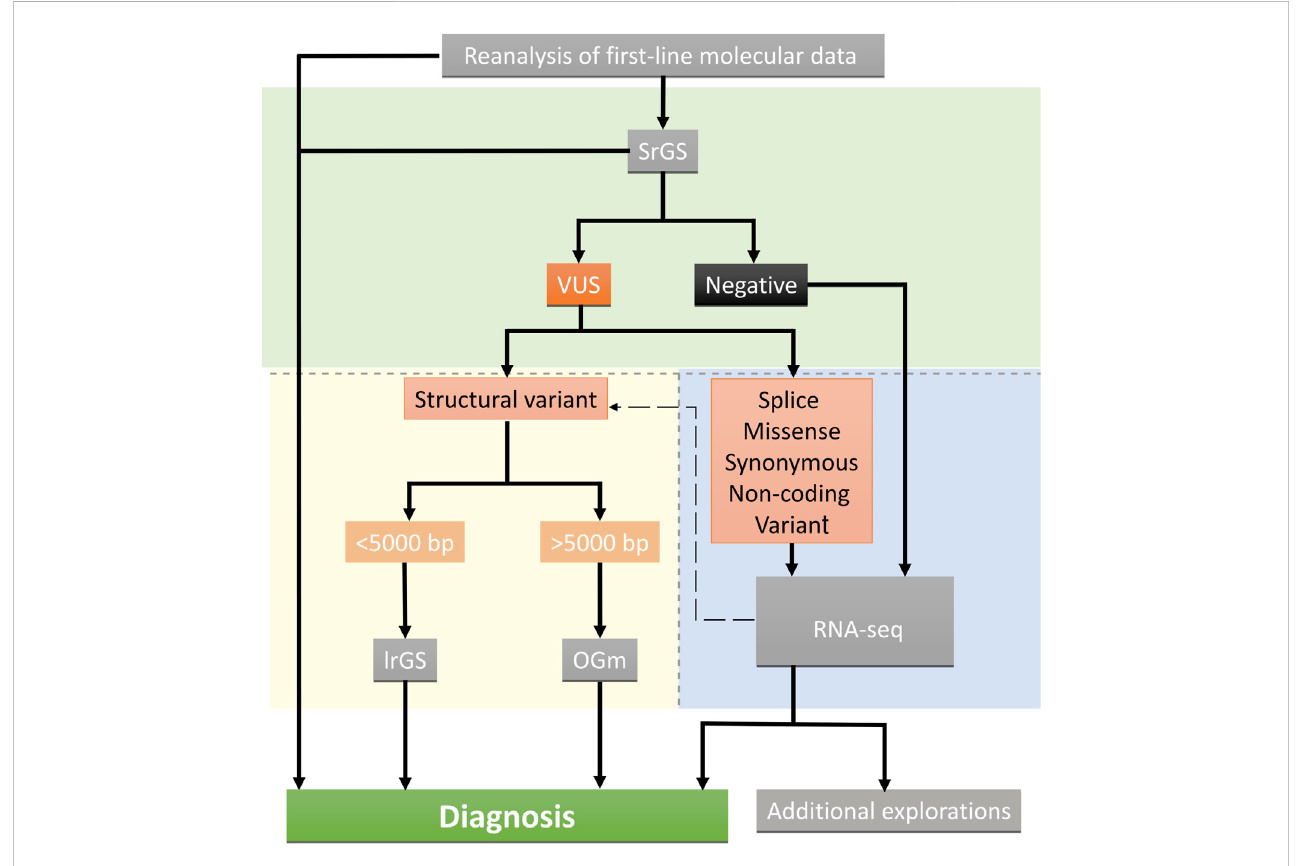
FIGURE 5 Suggested decision tree indicating the omic strategy implemented after inconclusive or negative results. Green, blue, and yellow backgrounds indicate short-read genome technologies, and transcriptome and long-read optical mapping technologies, respectively. Technics are shown in grey boxes.